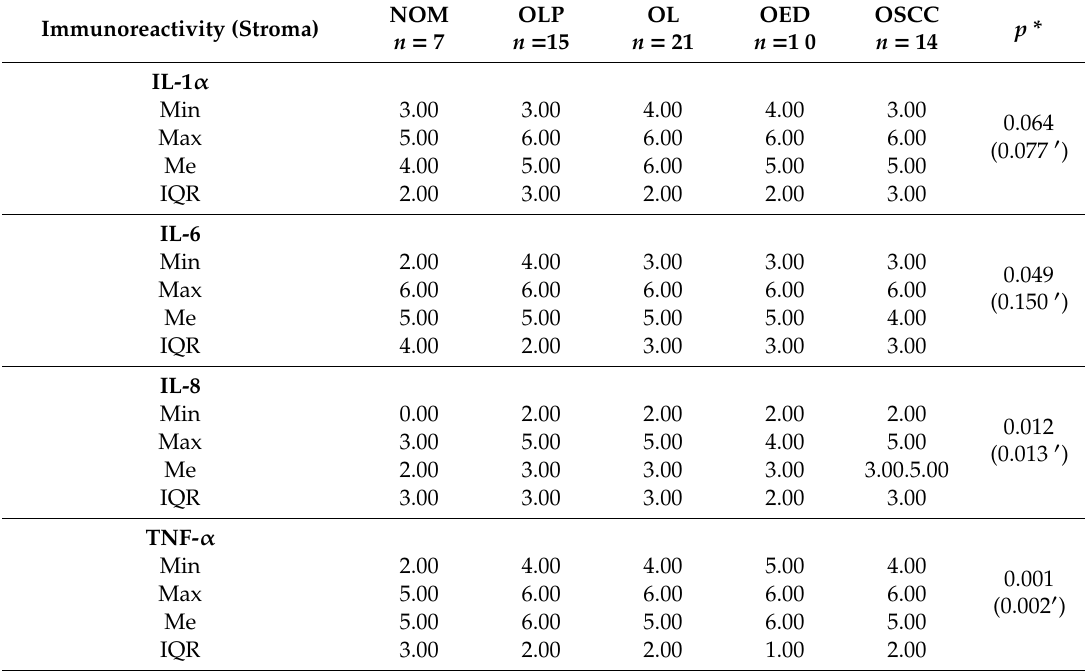
Table 4. Immunoreactivity for particular cytokines in